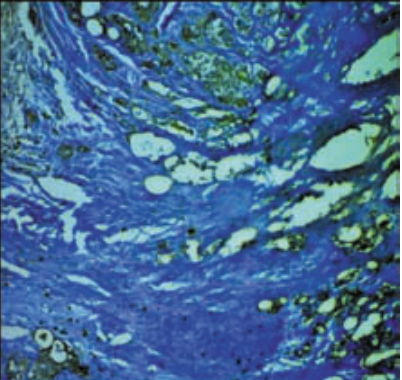
Fig. 8. New young collagen represented by blue colour and neoplastic epithelial cells in yellow colour. Herovici x 100